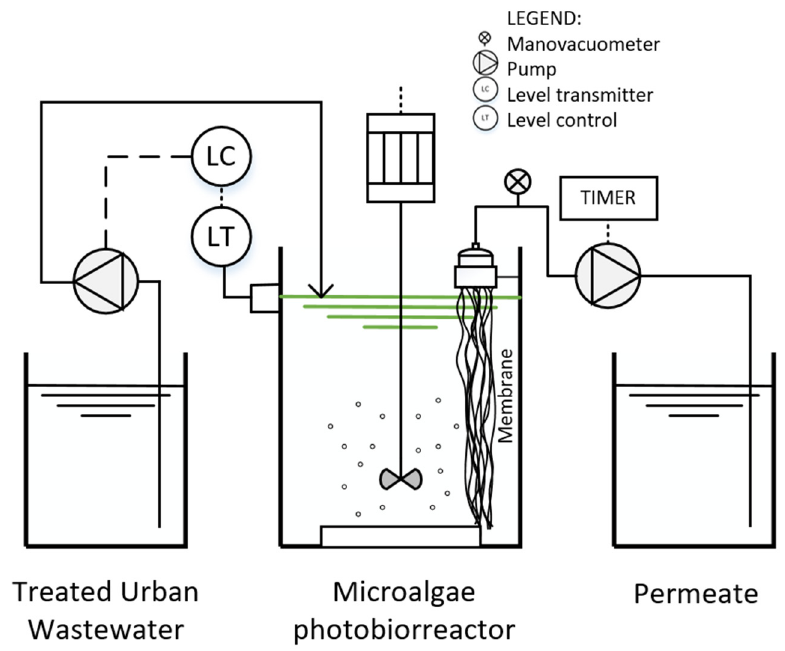
Figure 1. Experimental pilot plant used in the laboratory .